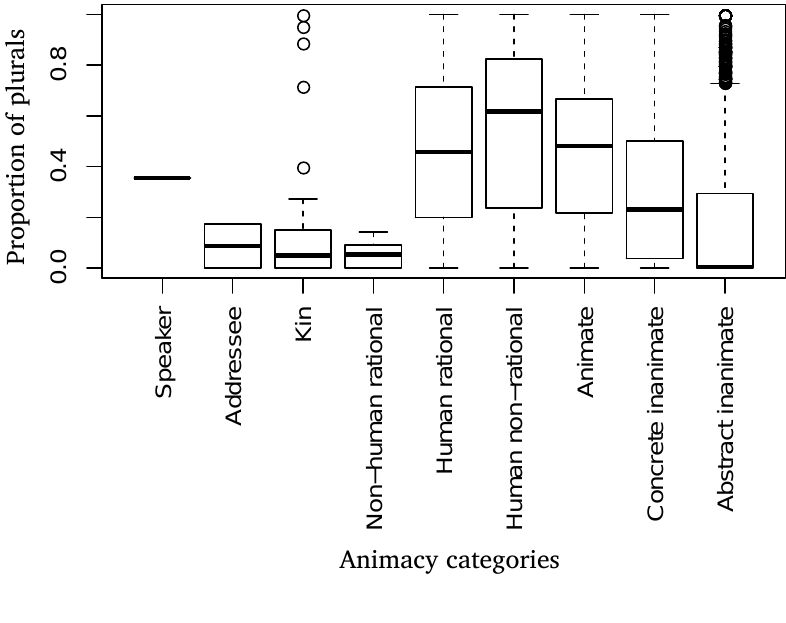
Figure 1: Box plot of proportion of plurals and